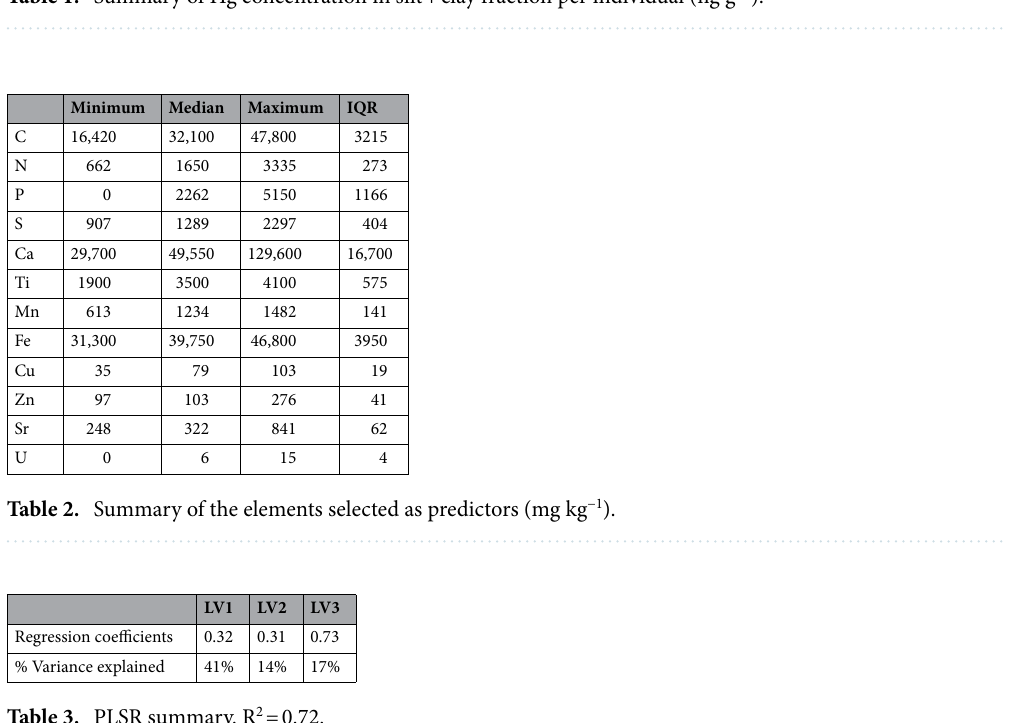
Table 1. Summary of Hg concentration in silt + clay fraction per individual (ng g −1 ).